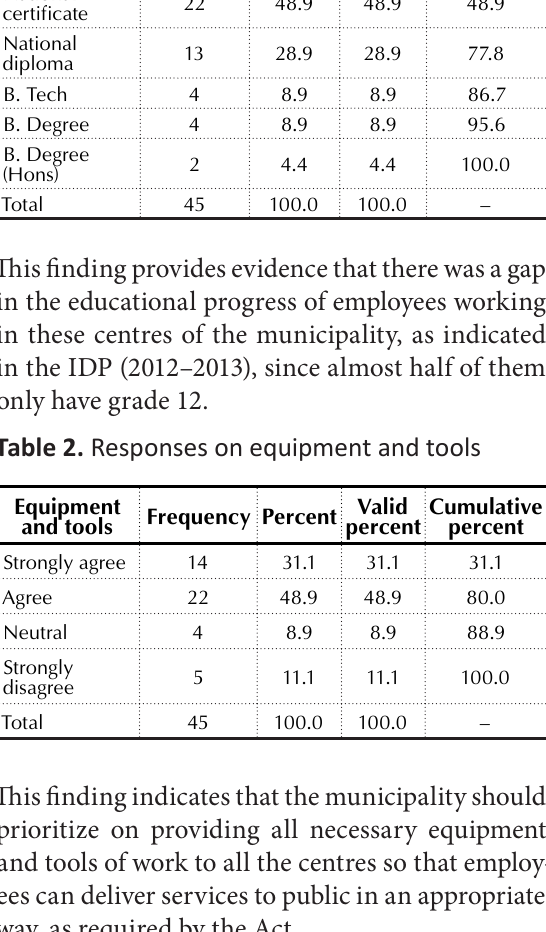
Table 3. Responses on communication